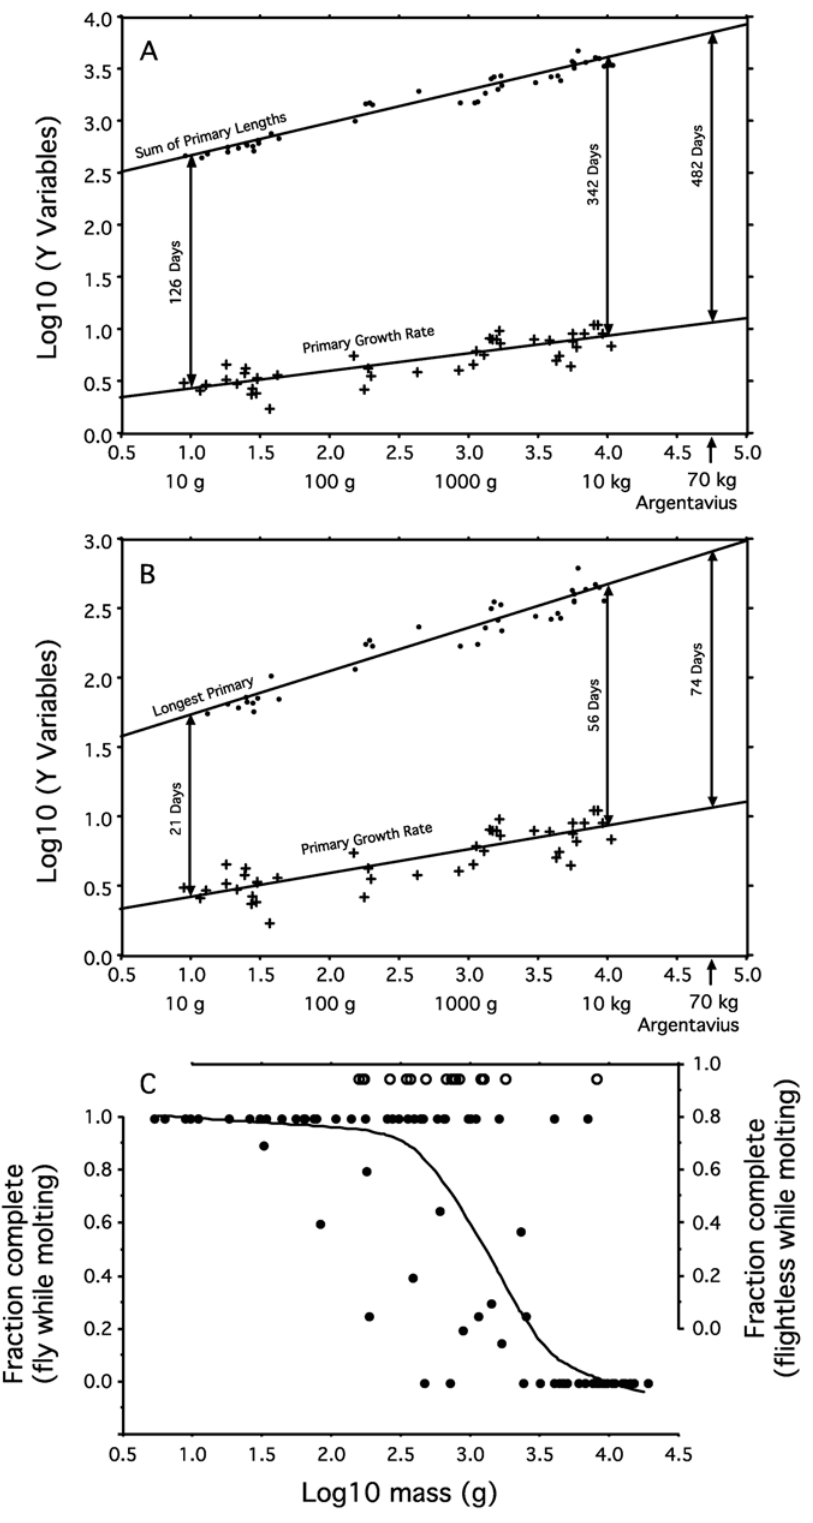
Figure 1. Relationships between mass and flight feather growth rate, length of flight feathers, and completeness of flight feather molts. (A) Allometric relationships between log 10 mass (g) and log 10 primary growth rate (mm/d) and log 10 summed primary length (mm). Arrows indicate the estimated time required to replace all primaries if they are grown one feather at a time for birds of 10 g, 10 kg, and for the extinct teratorn that weighed 70 kg. (B) Same as (A), except primary length is the longest primary. Arrows indicate the estimated time required to replace all the flight feathers in a simultaneous replacement of the primaries. (C) Fraction of individuals ( n =20 for most species, see Table S1) showing complete replacement of their primaries in their last molt, plotted against log 10 mass for 77 species that fly while molting (black dots and loess curve), and the same relationship for 17 species that replace their flight feathers simultaneously (open circles).